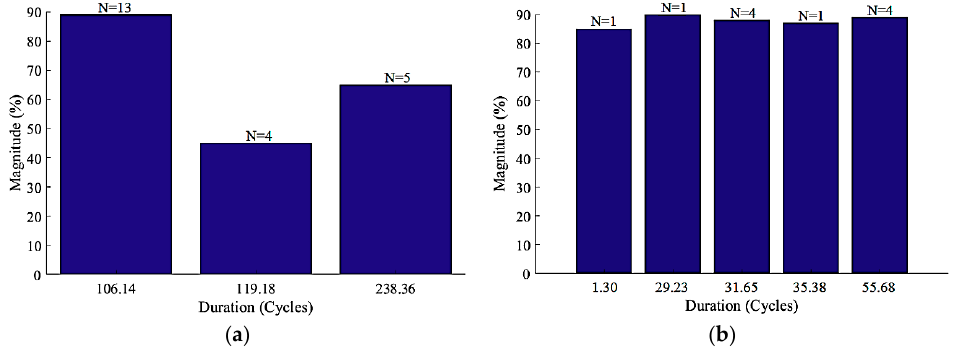
Figure 15. Voltage sag events at the main bus: ( a ) Voltage sag events without LSC and RPCs; and ( b ) voltage sag events with the LSC and RPCs active.